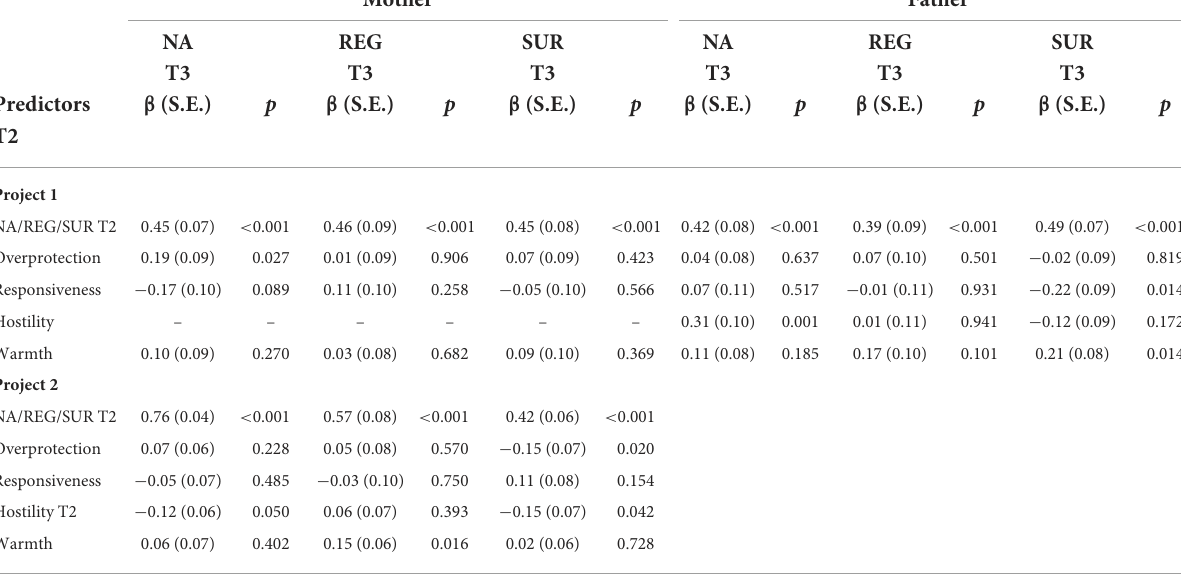
TABLE 6 Effects of parenting and infant temperament at T2 on infant temperament at